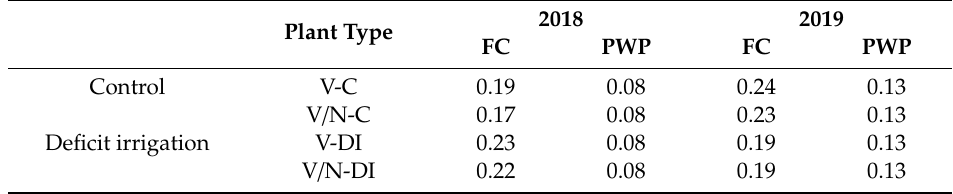
Table 2. Volumetric soil water content (m 3 m − 3 ) at field capacity (FC) and permanent wilting point (PWP) for each growing season (2018 and 2019), irrigation strategy (control (C) and deficit irrigation (DI)) and plant type (ungrafted (V) and grafted (V /